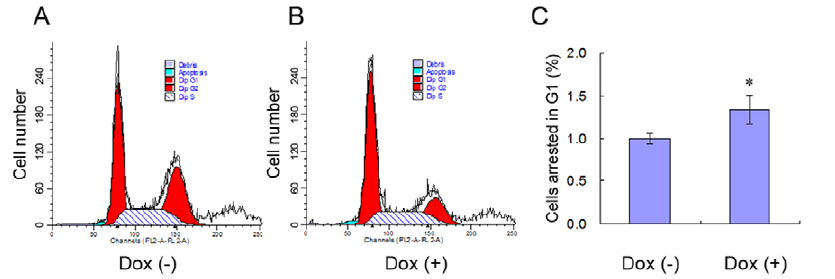
Figure 5. The expression of FN1BP1 induced G1 phase arrest. Synchronized by nocodazole for 20 h, Dox was added to half of the plates to induce the expression of FN1BP1 for 24 h. Following UV irradiation at 200 ( 6 100 m J/cm2) for 1 min, the cells were obtained after another 12-h incubation. Then the cells were collected and stained by propidium iodide (PI) for flow cytometry (FCM). (A–B) showed the representative figure of the result of FCM for DOX ( 2 ) and DOX ( + ), respectively. The statistical result is shown in (C). The statistical data demonstrate that more cells induced by Dox were arrested in the G1 phase compared with the non-Dox–induced cells. *P , 0.05, n=5.